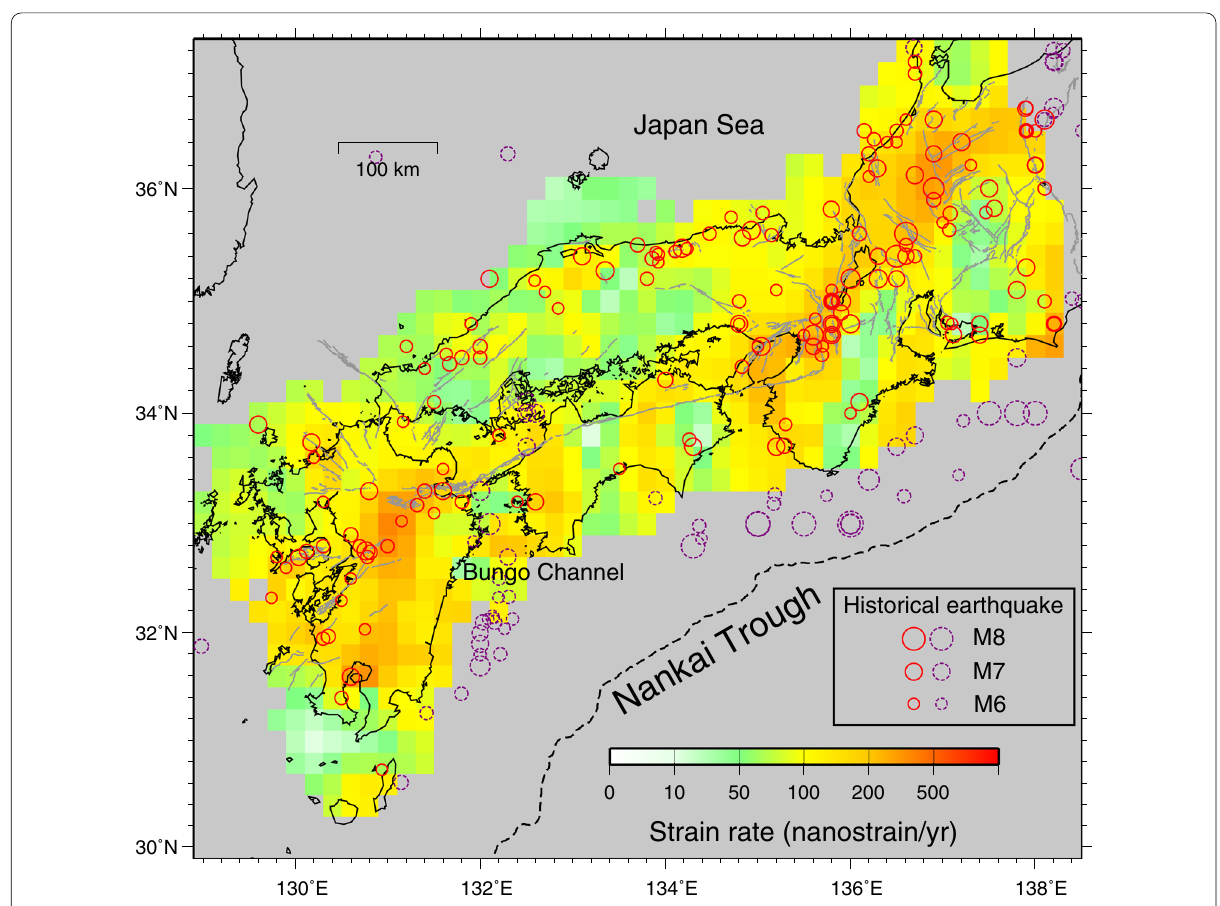
Fig. 1 GNSS strain rates and historical earthquakes in southwest Japan. Color scale indicates strain rates corrected for elastic deformation attributed to interplate coupling along the Nankai Trough from April 2005 to December 2009. Red circles indicate epicenters of M 599 to 2020, whereas purple dashed circles indicate subduction-type and/or out-of-bounds earthquakes beyond the scope of this study. Gray lines indicate major active faults (Earthquake Research Committee